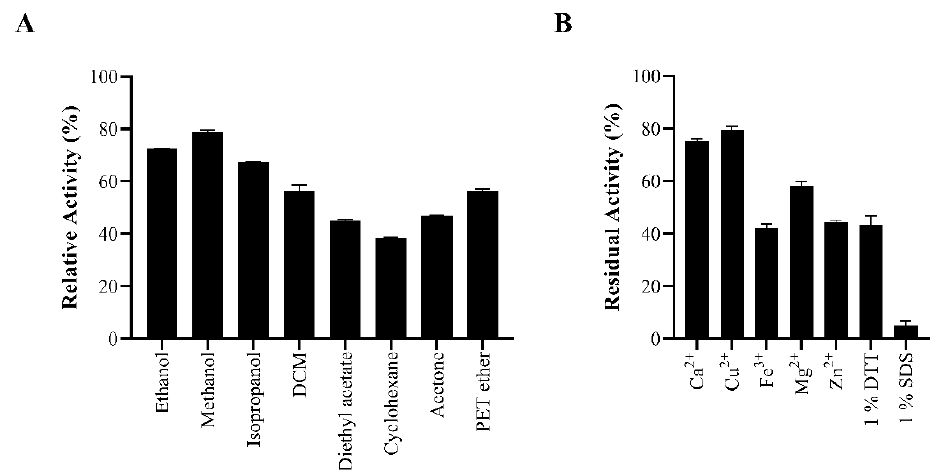
Figure 6. Inhibition by organic solvents and additives. The enzyme was assayed in the presence of ( A ) 20% selected organic solvent and ( B ) 1 mM metal ion, 1% DTT, and 1% SDS. Reactions proceeded for 10 min, and absorbance reading was measured at 410 nm. Assays were performed in triplicate, and error bars correspond to SEM. Relative activity was determined relative to a control reaction lacking any additive or organic solvent. DCM—dichloromethane, PET—petroleum ether.